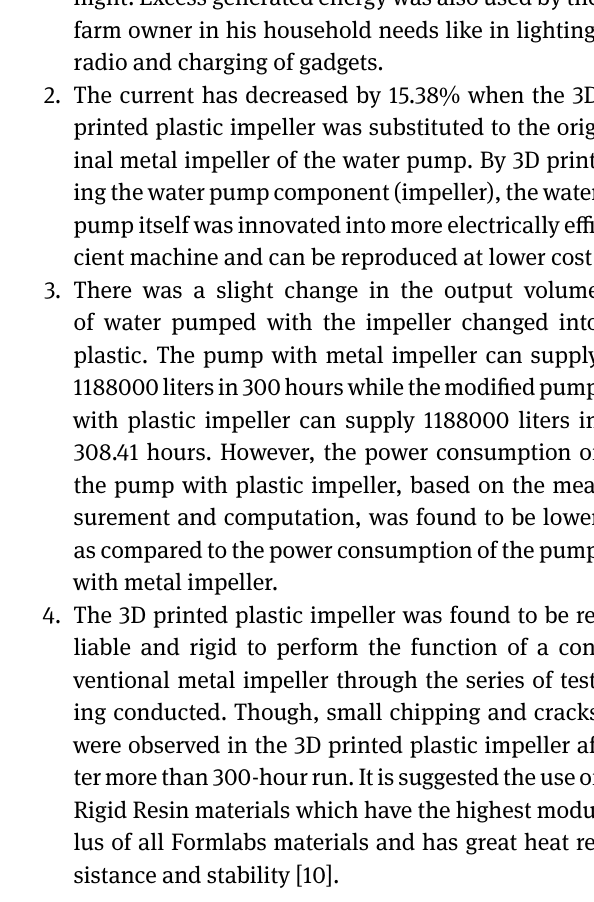
Table 1: Testing the Pump using Plastic Impeller